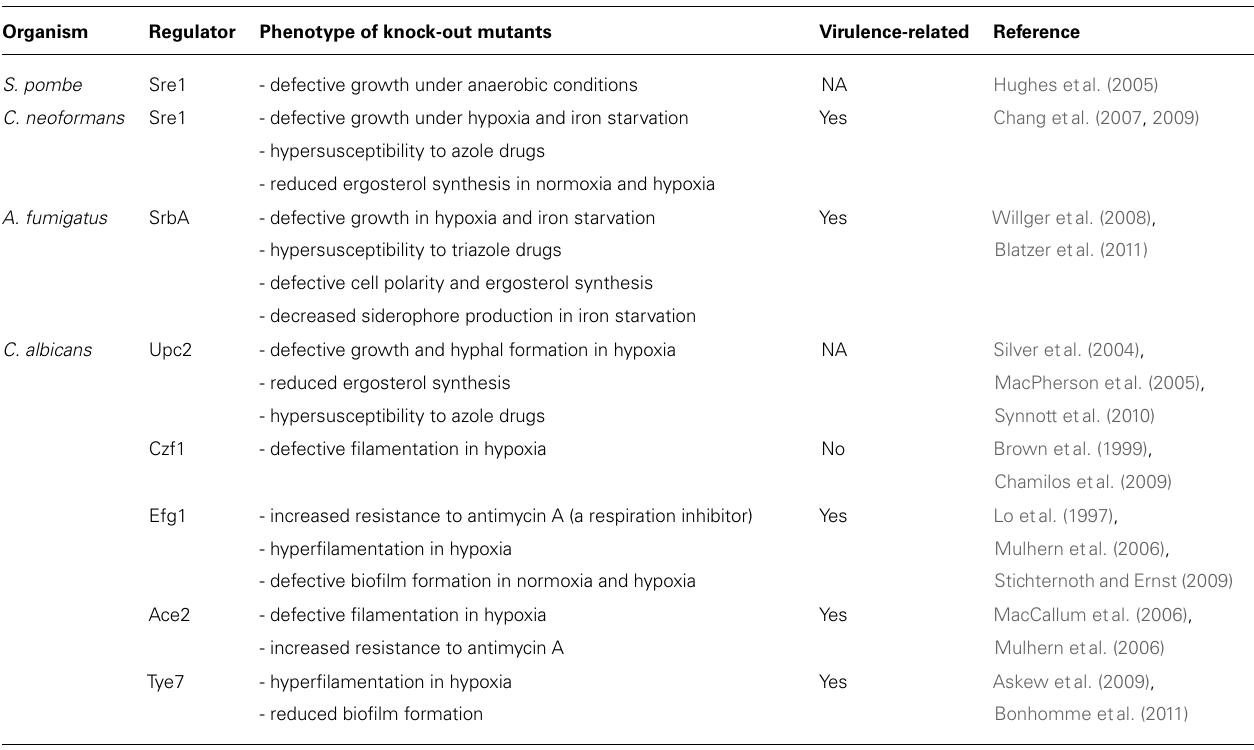
Table 1 | Phenotypes of key regulatory gene null mutants for hypoxia adaptation.